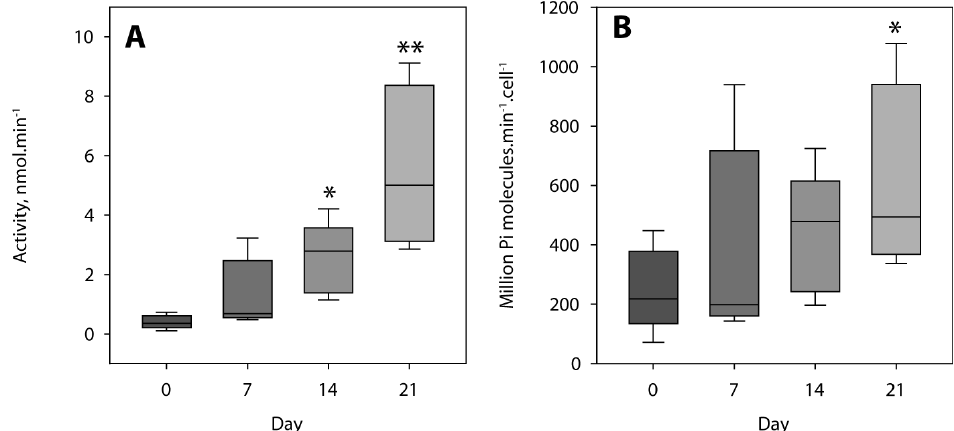
Figure 5. ATP hydrolysis by MOVAS cells expressed as ( A ) nmol min − 1 and ( B ) as million P i molecules min − 1 cell − 1 as determined by NMR (Table 1) and from IR (Table 3) ( n = 5). Results were considered significant when p < 0.05 (*), and highly significant when p < 0.01